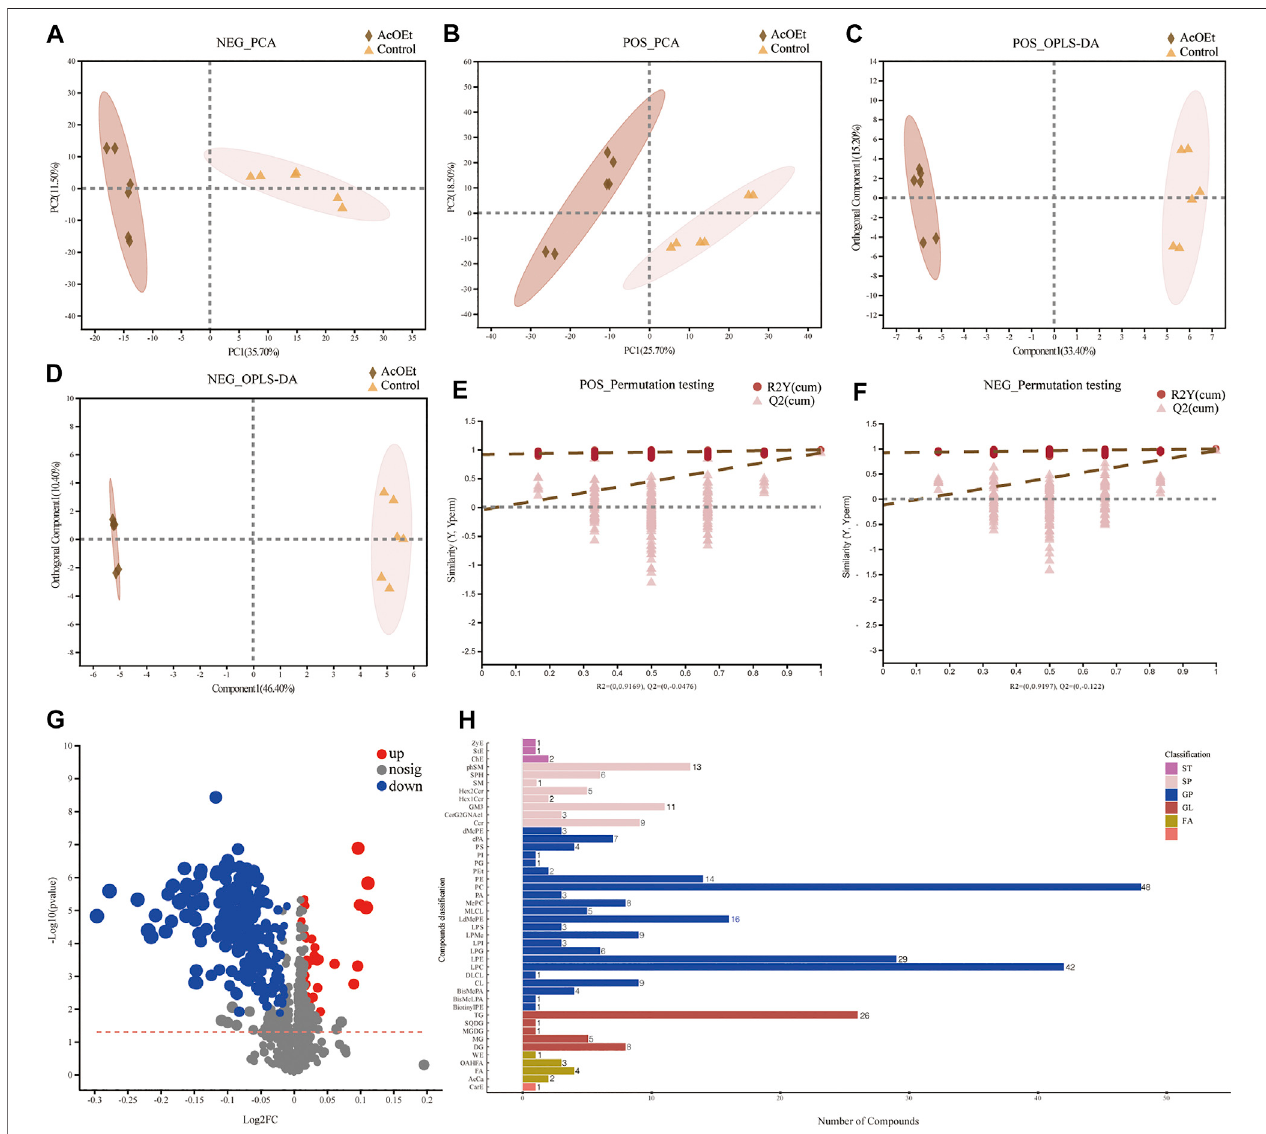
FIGURE 2 | Score plot of PCA and OPLS-DA models of zebra fi sh larvae (A, B) Scores plot of PCA model, obtained from AcOEtE group and control group (NEG and POS) (C,D) ScoresplotofOPLS-DAmodel, obtainedfromAcOEtE groupandcontrolgroup(NEGand POS) (E,F) ThescoreoftheOPLS-DAmodel, obtained from the AcOEtE group and control group (NEG and POS). The R 2 factor estimates a good fi t, while the Q 2 coef fi cient determines the predictive value of the created model, referring to the percentage of correctly classi fi ed samples using cross-validation. Two hundred permutations were performed, and the resulting R 2 and Q 2 values wereplotted(Redcircle): R 2 (Pinktriangle):Q 2 .Thetwodashed linesrepresent theregressionlinesof R 2 and Q 2 ,respectively (G) volcanoplotofModel-Control,theblue pointsrepresentthedown-regulatedlipids,redpointsrepresenttheup-regulatedlipids(VIP > 1.0, p -value < 0.05) (H) Thenumberofdetectedlipidswasbasedonanon- targetedlipidomicsstrategybetweentheAcOEtEandcontrolgroups.Thehorizontalaxisrepresentsthenumberoflipidsinthesubclass,andtheverticalaxisrepresents the subclasses of